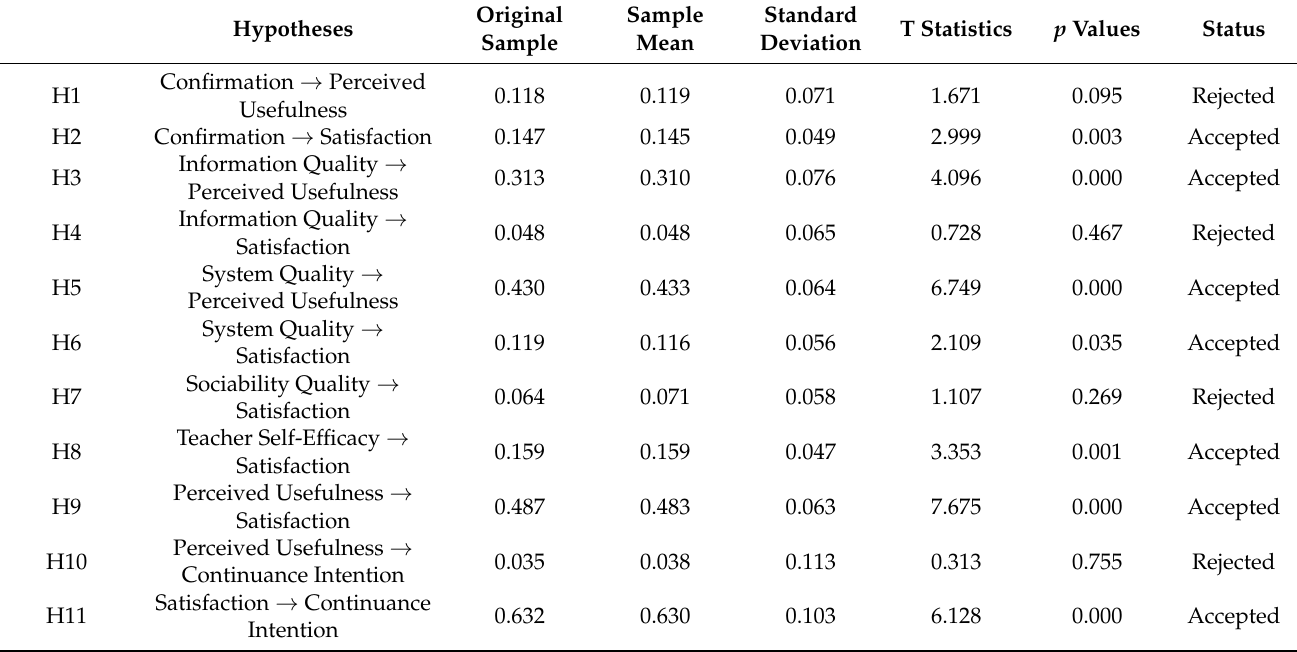
Table 3. Hypotheses